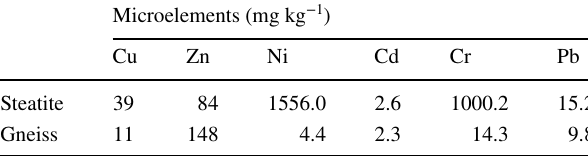
Table 1 Chemical properties of the rock